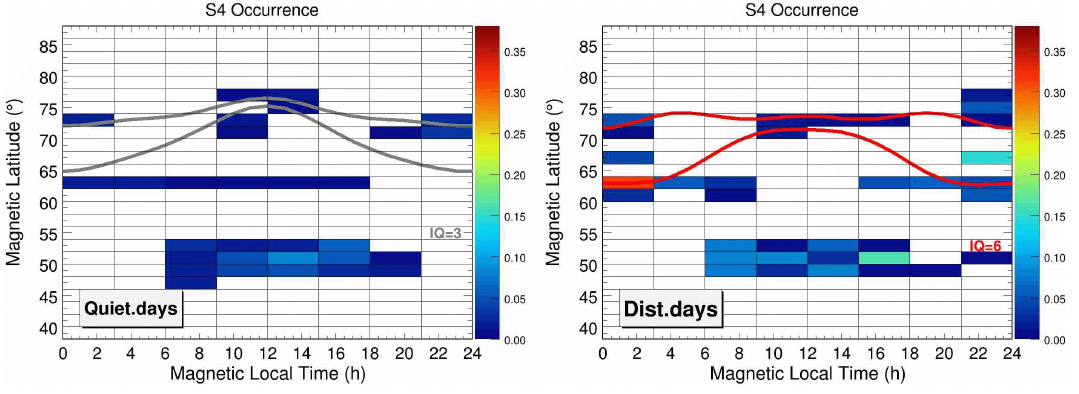
Fig. 7. Maps of S 4 percentage of occurrence merging data from all stations: left is for the quiet days with the IQ=3 oval in grey, while right is for disturbed days with the IQ=6 oval in